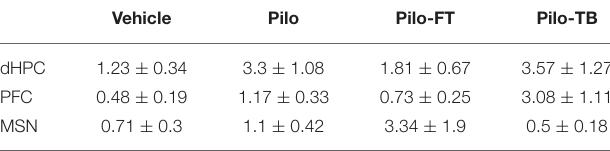
TABLE 1 | R Average spike rate (spikes/min ± SEM) during the novel object task. Vehicle